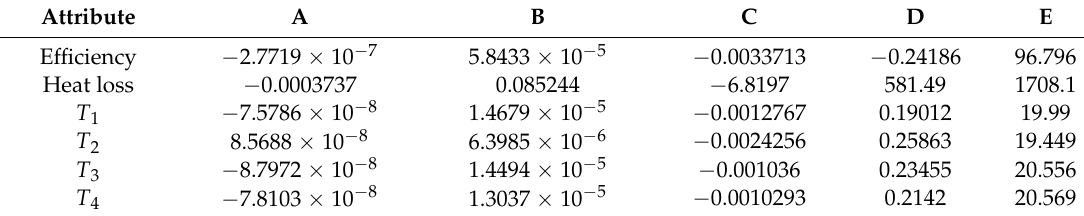
Table 5. Polynomial equations during